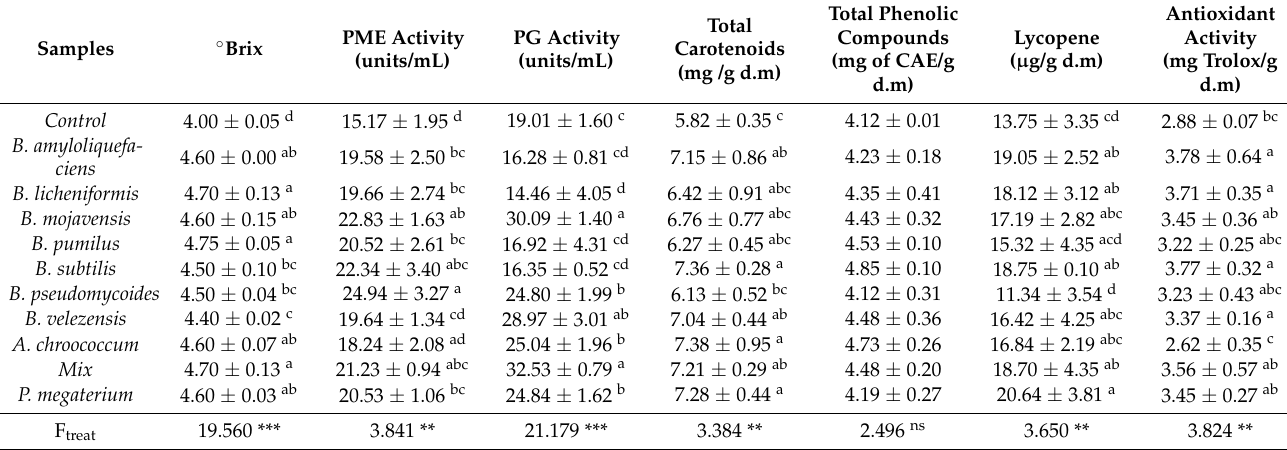
Table 6. Effect of PGPB strains on total soluble solids ( ◦ Brix), PME and PG activity (units/mL), total carotenoids (mg /g d.m), total phenolic compounds (mg of CAE/g d.m), lycopene concentration ( µ g /g d.m) and antioxidant activity (mg Trolox/g d.m) of harvested